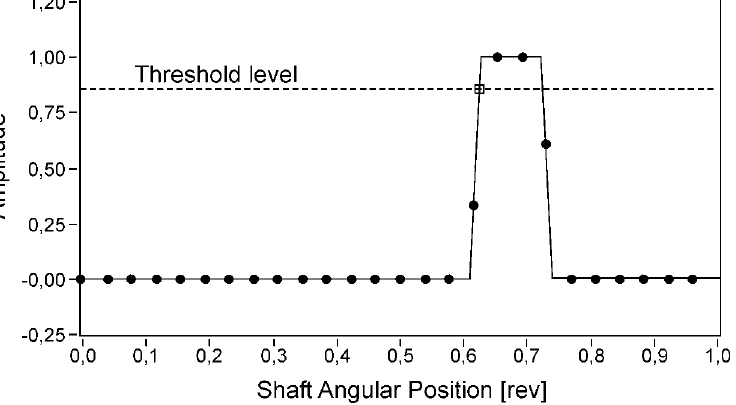
Fig. 3. Determination of the pulse arrival time.